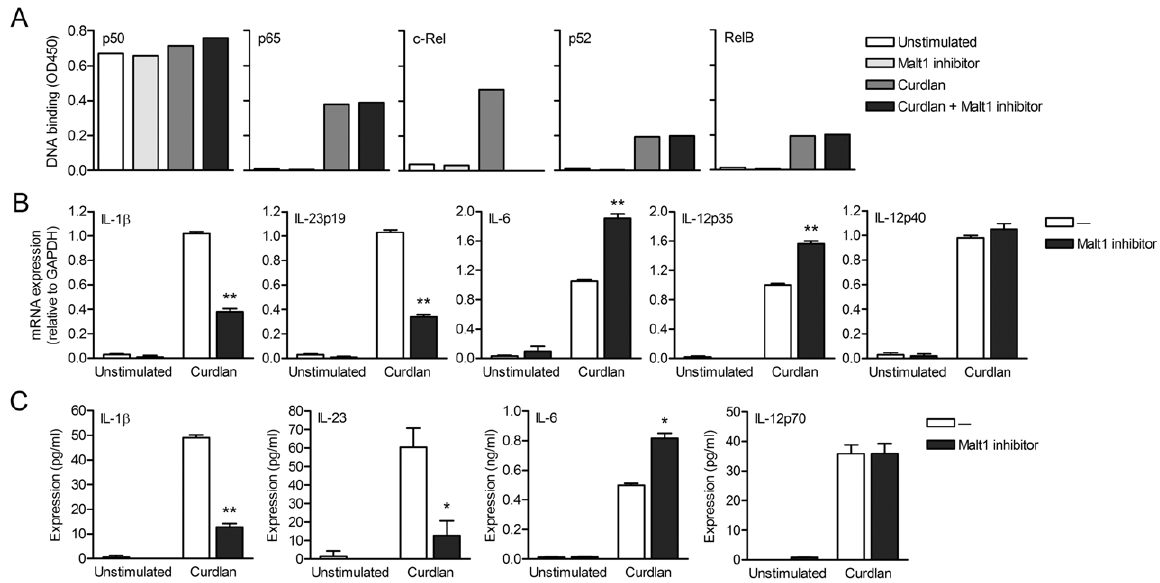
Figure 3. Malt1 paracaspase activity is required for c-Rel activation and cytokine induction by dectin-1. (A) DNA binding of NF- k B subunits in nuclear extracts of curdlan-stimulated DCs after inhibition of Malt1 paracaspase activity by z-VRPR-FMK. Data are representative of three independent experiments. (B) Quantitative real-time PCR for indicated mRNAs in curdlan-stimulated DCs after Malt1 paracaspase inhibition. Expression is normalized to GAPDH and set at 1 in curdlan-stimulated cells. Data are mean 6 s.d. of three independent experiments, ** p , 0.01 (Student’s t -test). (C) Cytokine production was determined by ELISA in supernatants of DCs stimulated with curdlan in the absence or presence of Malt1 paracaspase inhibitor. Data are mean 6 s.d. of duplicate cultures, and are representative of five independent experiments, * p , 0.05 and